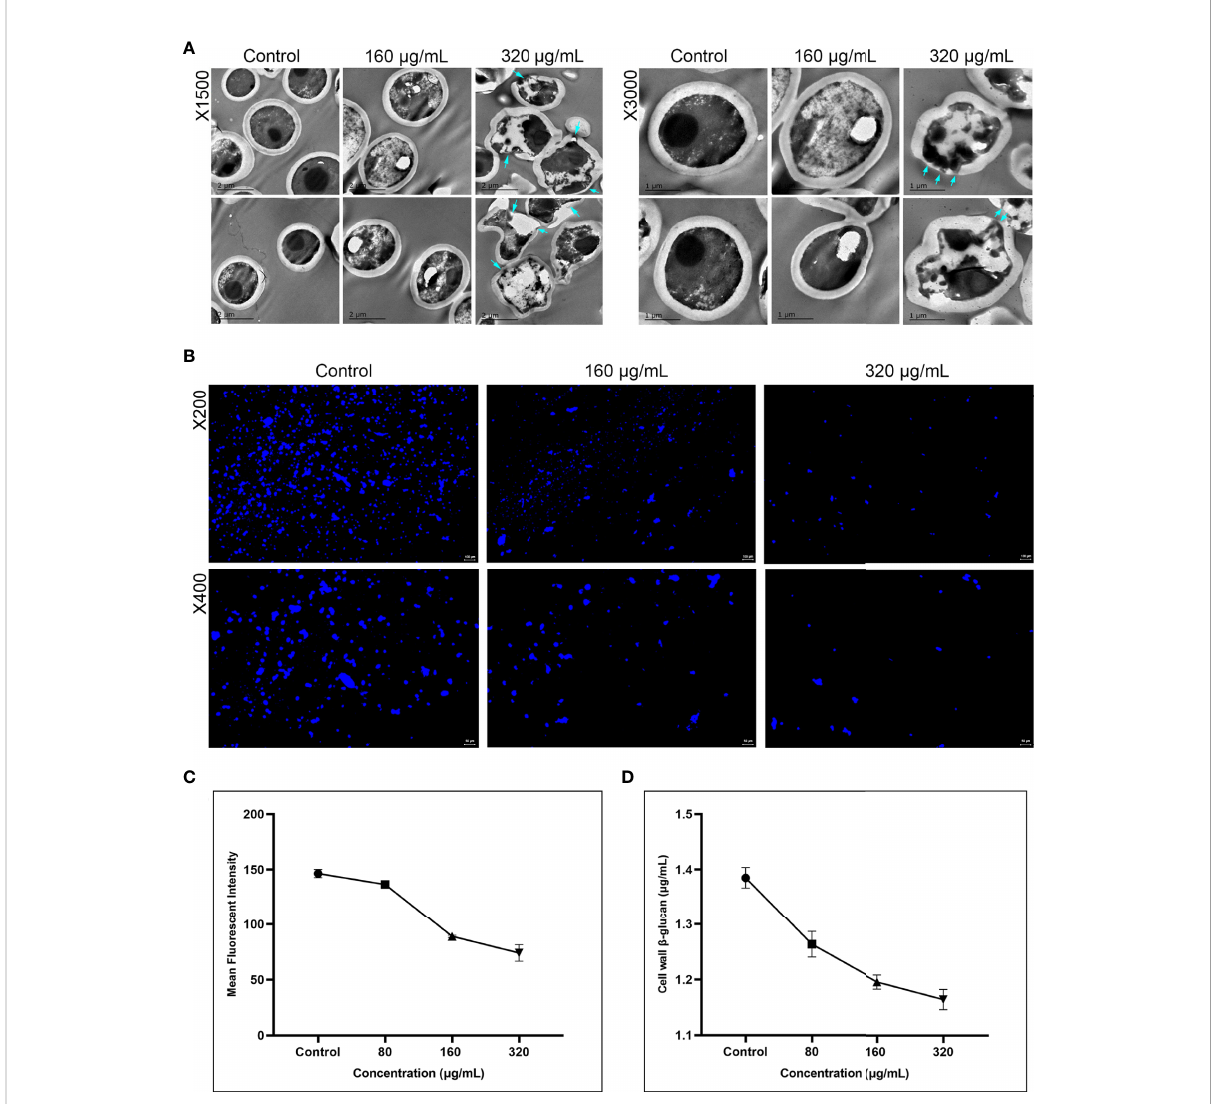
FIGURE 4 (A) The inhibitory effects of magnolol on the cell wall ultrastructure of C. albicans assessed using TEM under magni fi cations of 1500 and 3000. At 320 m g/mL, C. albicans ultrastructure showed partial thinning of cell walls and even rupture, with cytoplasmic leakage (blue arrow). (B) Magnolol could exert signi fi cant antifungal effects by inducing C. albicans cell wall stress via CFW staining under magni fi cations of 200 and 400. (C) CFW fl uorescence quantitative results showed the inhibitory effects of magnolol against C. albicans cell walls were concentration-dependent ( P < 0.001). (D) The b -glucan quantitative detection assay showed C. albicans cell wall b -glucan content decreased signi fi cantly under the action of magnolol in a concentration-dependent manner ( P <